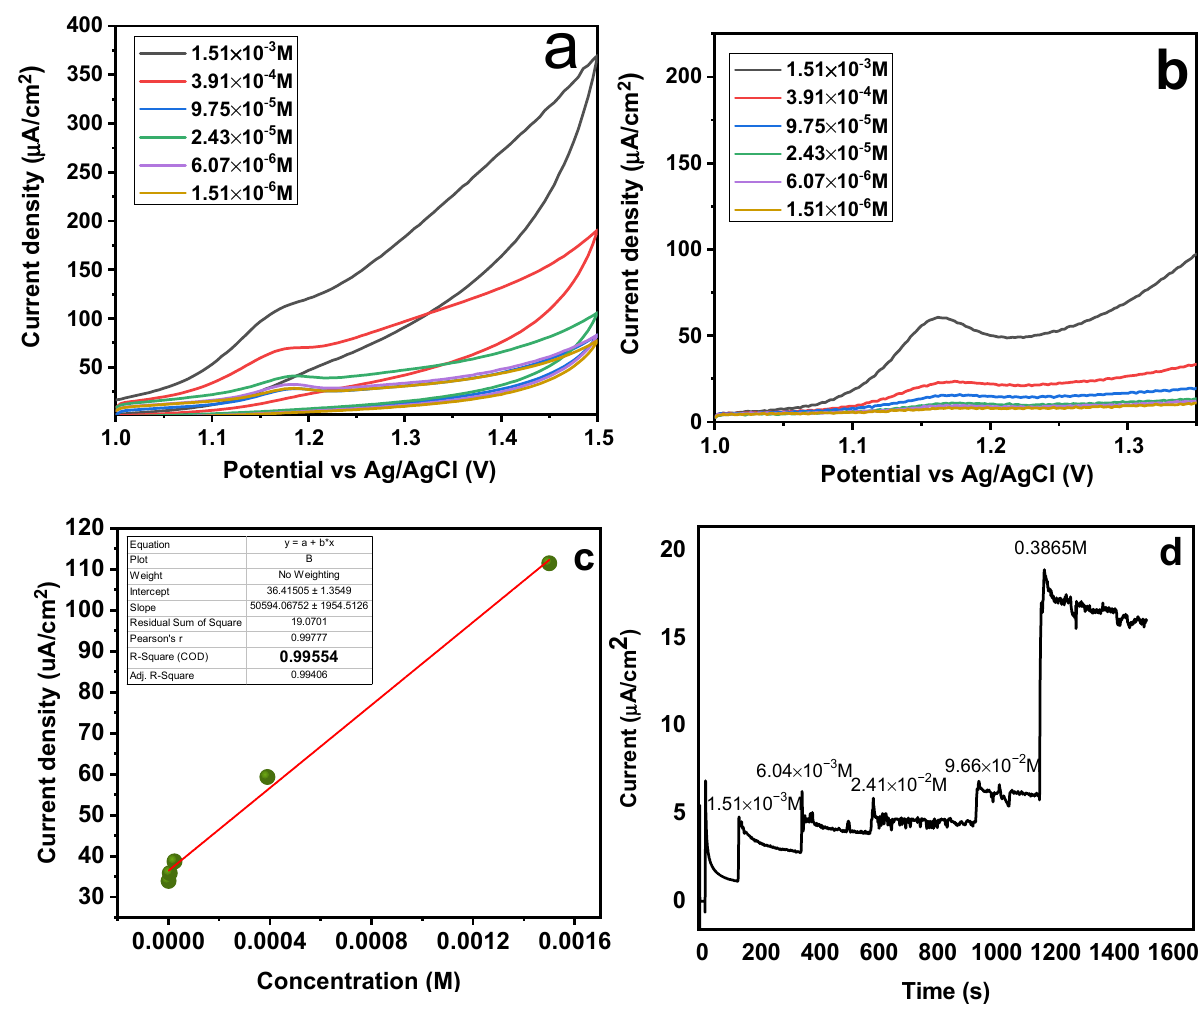
Figure 11. Effect of concentration on ( a ) CV and ( b ) SWAdASV for Fe 3 O 4 @MIP/CPE sensors ( c ) Calibration curve ( d ) Chronoamperometric response of magneto-sensors (potential 1.18 V). An interference analysis was also carried out to assess the magneto-sensors’ strong specificity and selectivity toward the template (SY). Congo red dye, glucose, urea, and ascorbic acid were chosen and thought to be the main interfering species, especially working with realistic materials (Figure 12) [53,54]. The findings demonstrate that no discernible interaction of the interferents was noted, because the current intensity barely changed. This demonstrated how highly selective the magneto-sensor was for SY dye.